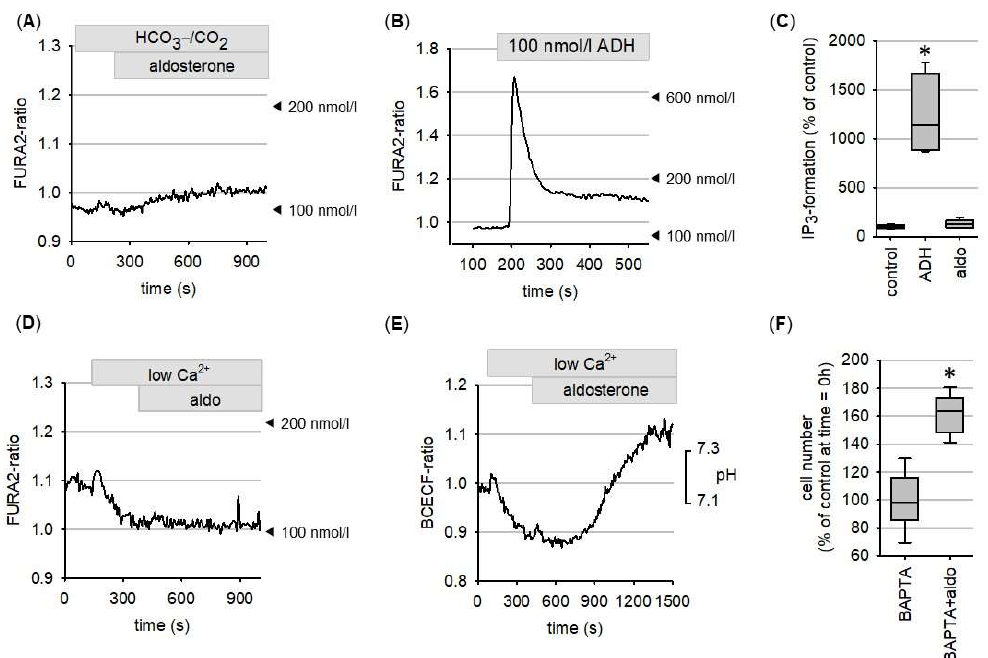
Figure 4. ( A ) Aldosterone (10 nmol/L) induces only a minor increase in cytosolic Ca 2+ , in contrast to ( B ) 100 nmol/L ADH. ( C ) ADH but not aldosterone induces the formation of IP 3 (N = 5). ( D ) At low extracellular Ca 2+ , to prevent relevant Ca 2+ influx, aldosterone induces no increase of cytosolic Ca 2+ . ( E ) Aldosterone-induced alkalinisation and ( F ) aldosterone-induced increase in cell number are independent of extracellular Ca 2+ (N = 10). * = p < 0.05 versus respective control.